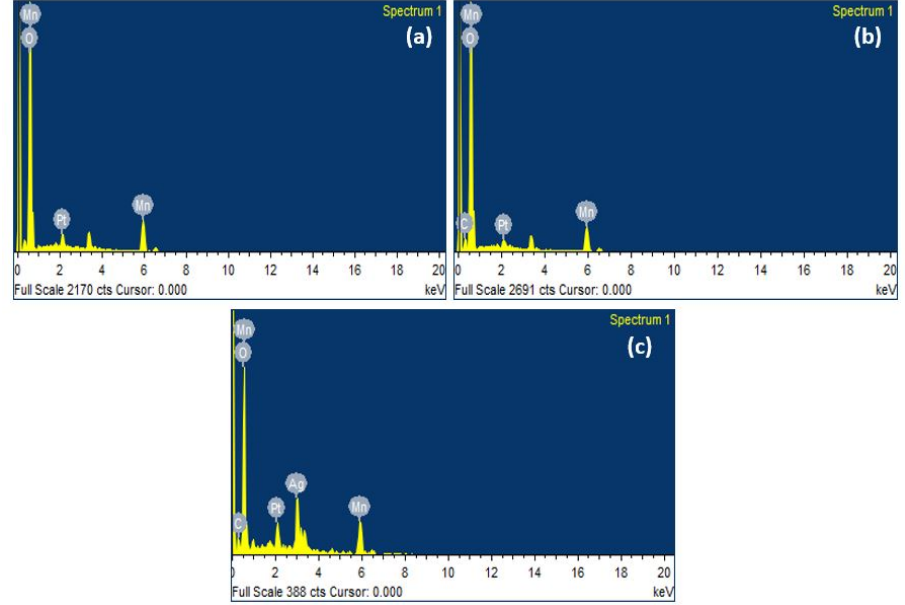
Figure 4. EDX spectrum of ( a ) pure MnO 2 , ( b ) rGO@MnO 2, and ( c ) Ag-rGO@MnO 2 nanocomposite. Table 1. EDX analysis showing the elemental composition of Ag-rGO@MnO 2 nanocomposite. Element